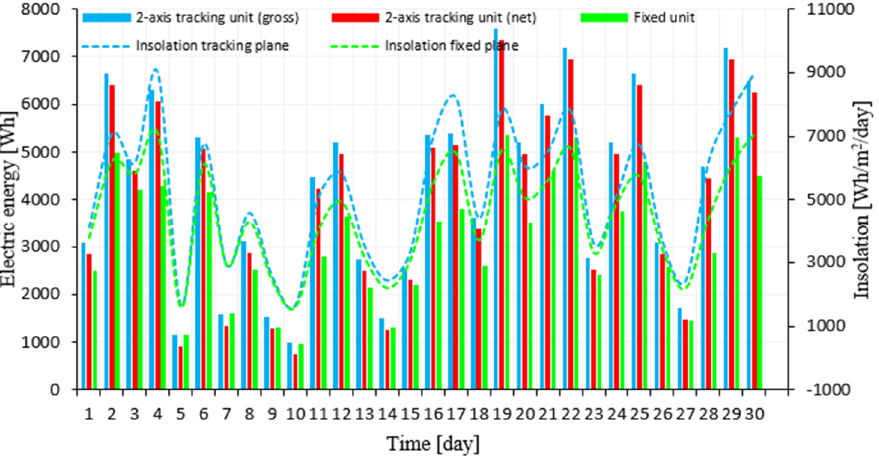
and dual-axis tracking configurations in April 2017.